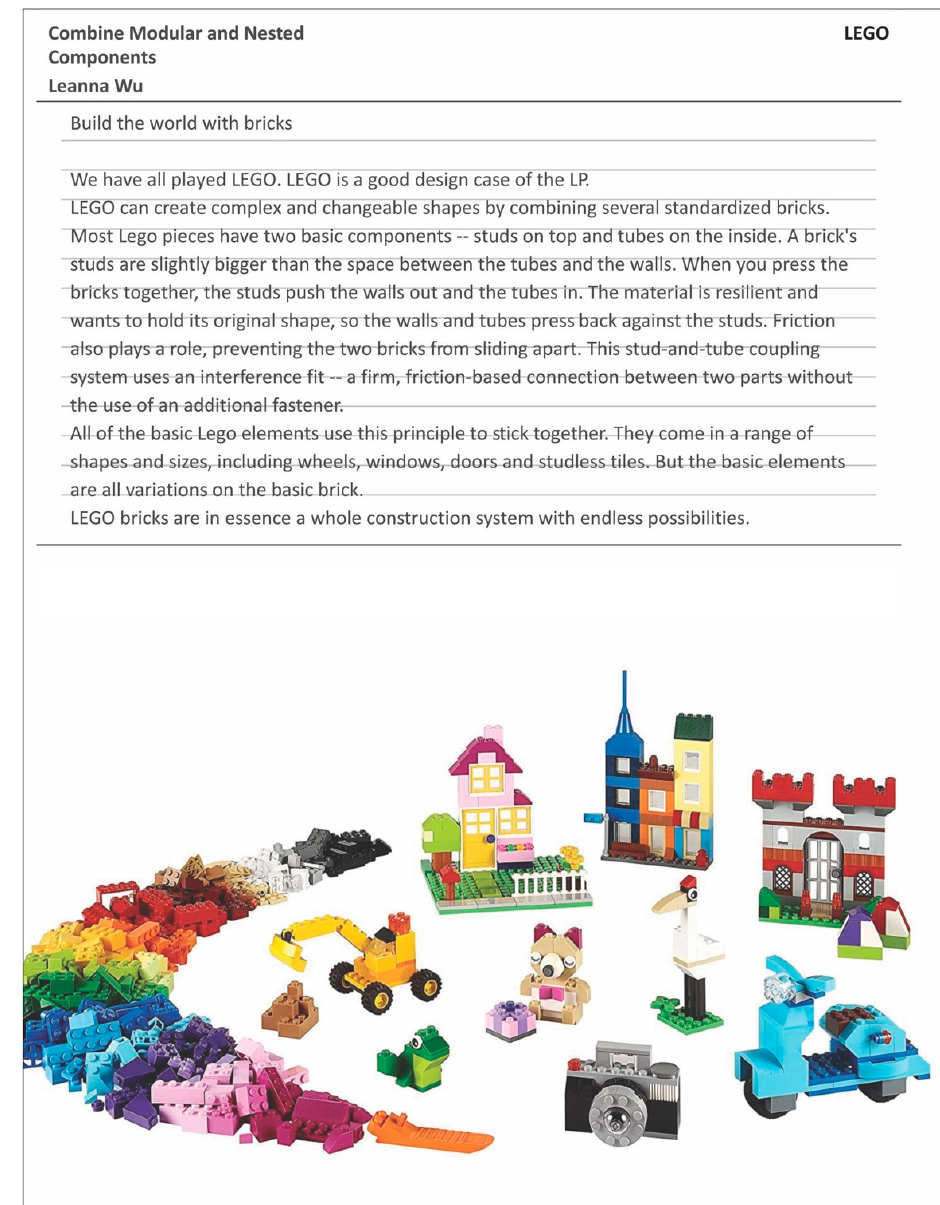
Figure 5. Example slide of LP in design ASU. Available online: https://entertainment.howstuffworks.com/lego.htm; https://www.amazon.com/LEGO-Classic-Largr-Creative-Brick/dp/B00NHQF6MG (accessed on 26 January 2022).